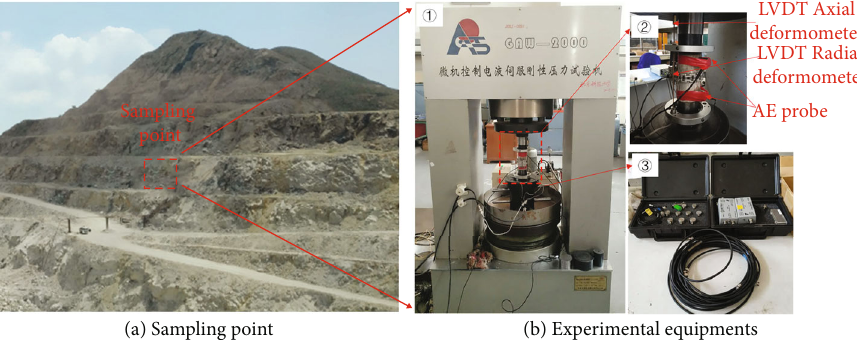
Figure 1: Jiguanshan mining slope sampling point and experimental equipment. (a) Sampling point. (b) Experimental equipment.